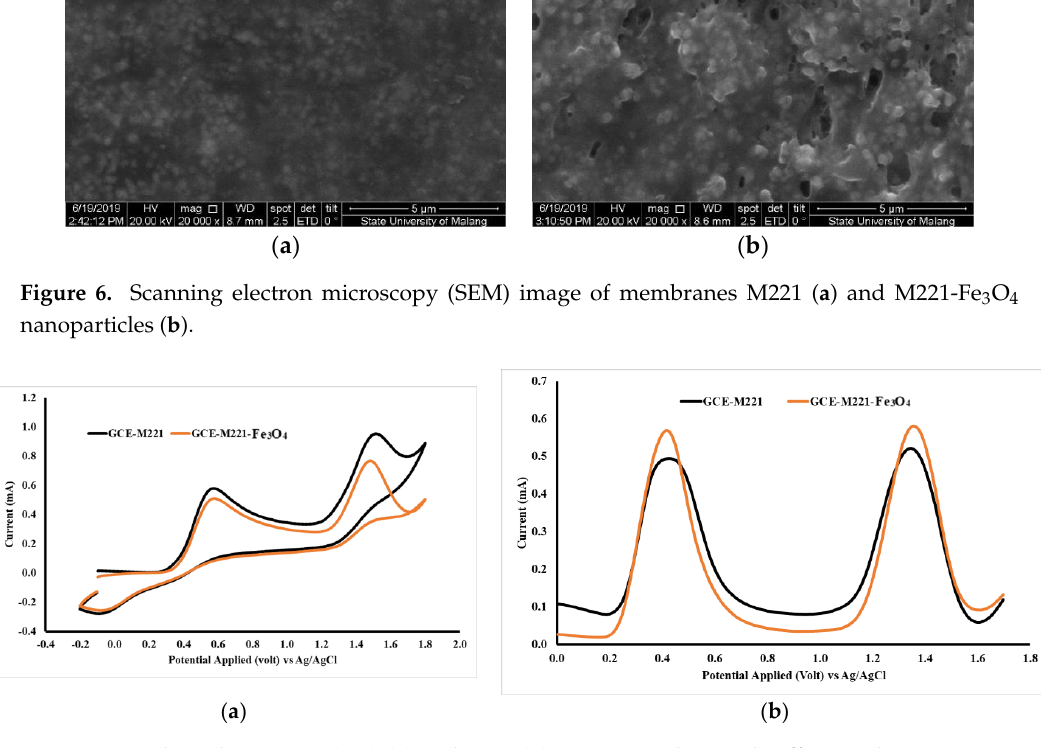
Figure 7. Cyclic voltammetry (CV) ( a ) and DPV ( b ) acetaminophen and caffeine voltammograms, 1 mM each in BR with a pH of 7, measured by working electrodes of GCE-M221 (GCE modified by M221), GCE-M221-Fe 3 O 4 (GCE modified by M221 and Fe 3 O 4 nanoparticles).